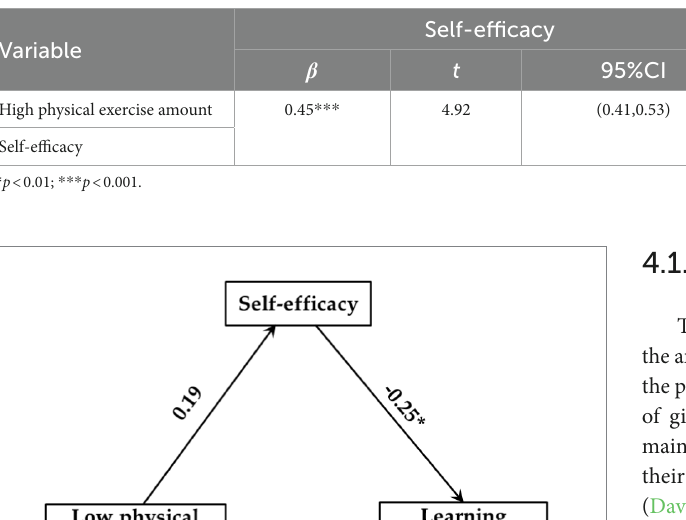
TABLE 8 Linear regression analysis of self-efficacy between high physical exercise amount and learning burnout ( n = 152).